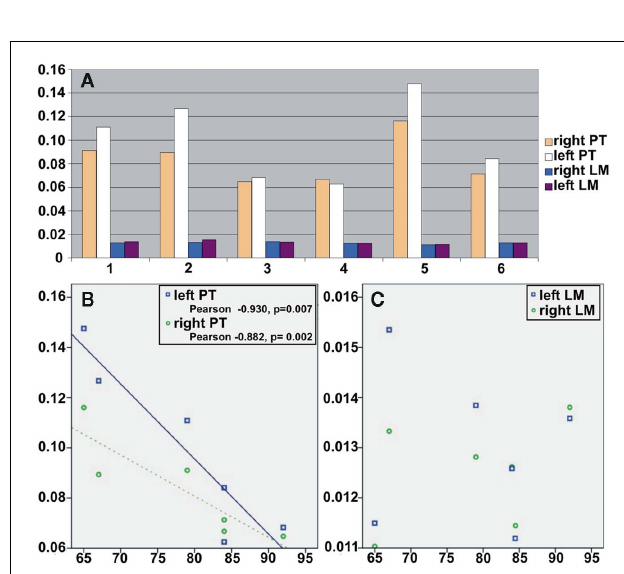
FIGURE 5 |Three dimension reconstruction of the brainstem. Serial FOMs are three-dimensionally reconstructed and a 3D data set is produced with a vector in each voxel representing the 3D fiber orientation.The example shows one original axial (A) section, and a calculated sagittal (B) , and horizontal (C)